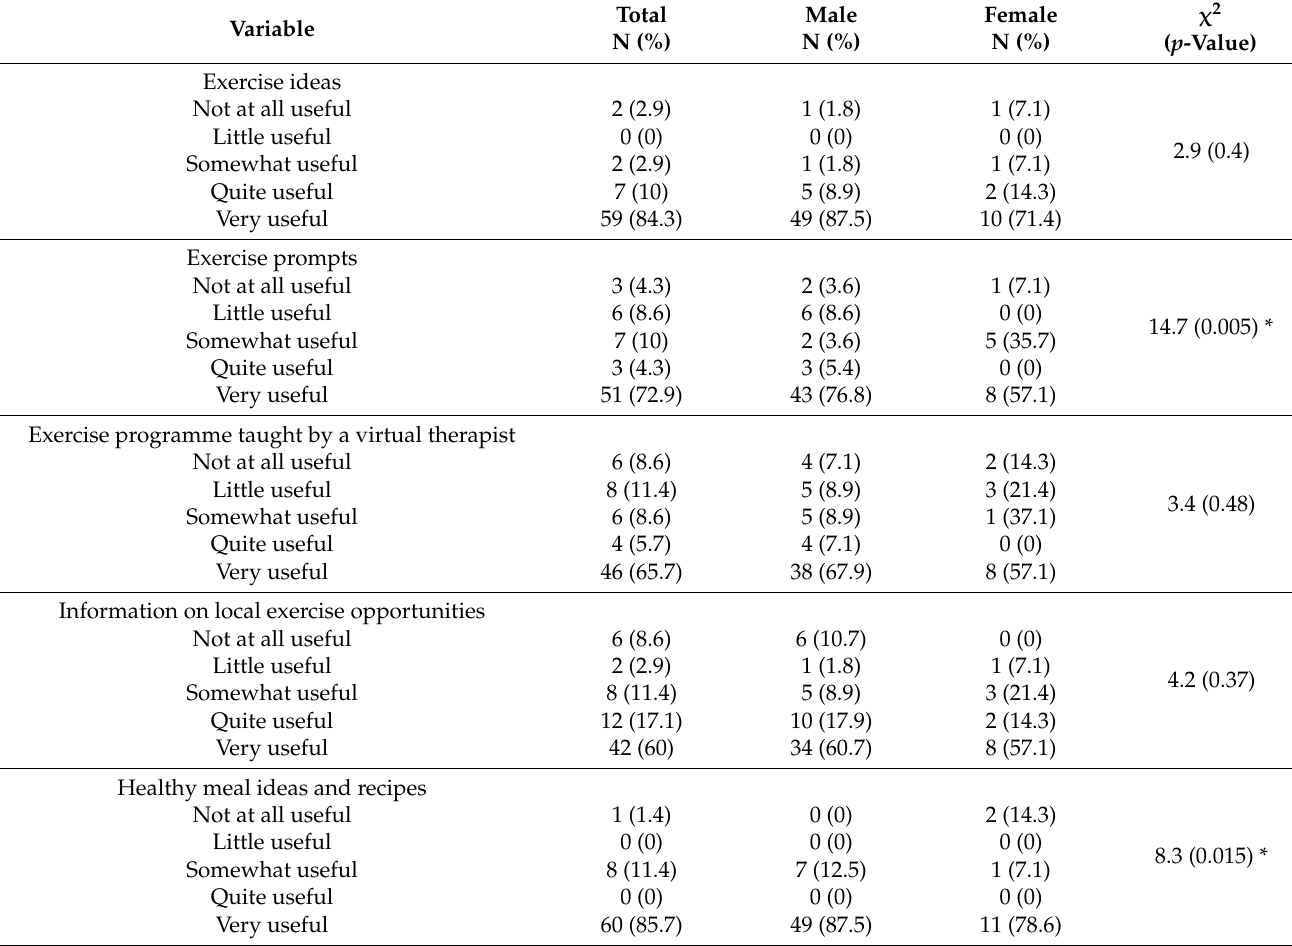
Table 4. Preferences of older adults about useful advices of technology-based cardiac physical therapy